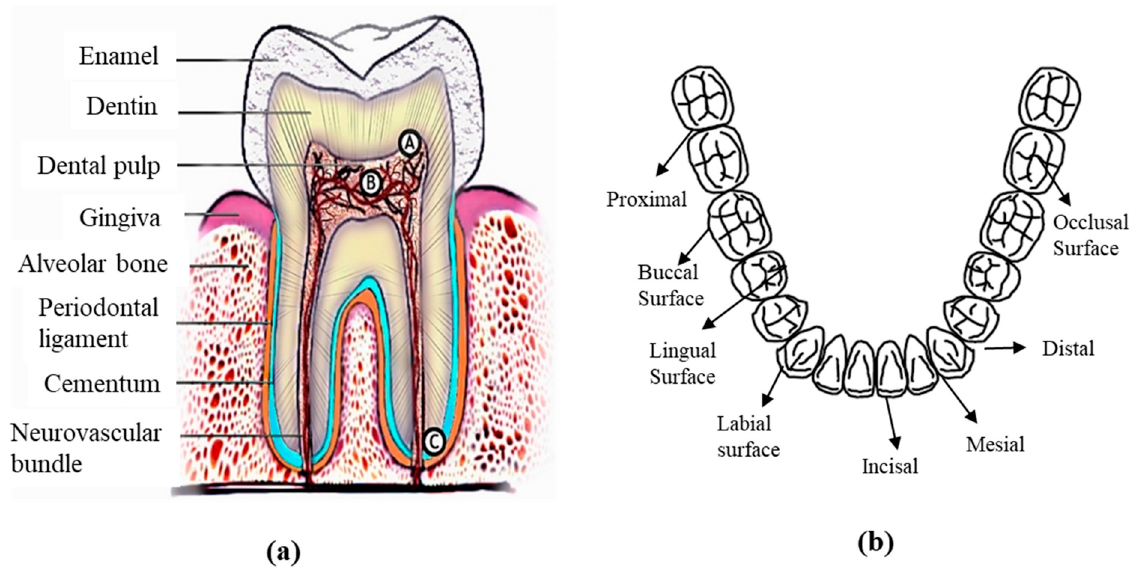
Figure 1. Scientific terminologies related to ( a ) tooth geometry [54] ( b ) tooth surfaces.